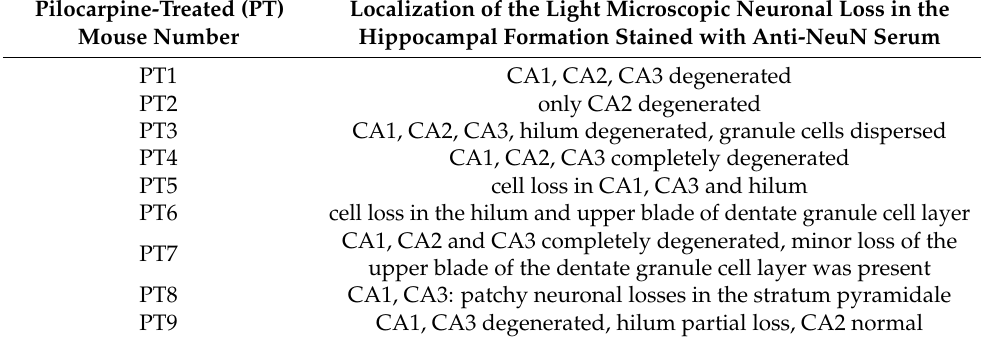
Table 1. The degree of HS and the localization of neuronal degeneration in PT mice. The fields of the Ammon’s horn (CA), hilum, and granule cell layer of the DG are indicated. The observations are based on the qualitative light microscopy of the NeuN immunostained histological sections of the HF. Pilocarpine-Treated